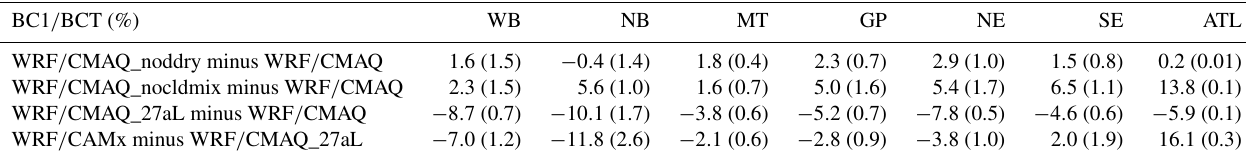
Table 5. Differences in BC1 / BCT (%) averaged over 24h in the diurnal cycle over seven subregions in summer between WRF / CMAQ and its sensitivity simulations and between WRF / CAMx and WRF / CMAQ_27aL. The numbers in parentheses represent the range of the diurnal differences in BC1 / BCT (%), namely the maximum minus the minimum within the diurnal cycle of the difference in BC1 / BCT. BC1 / BCT